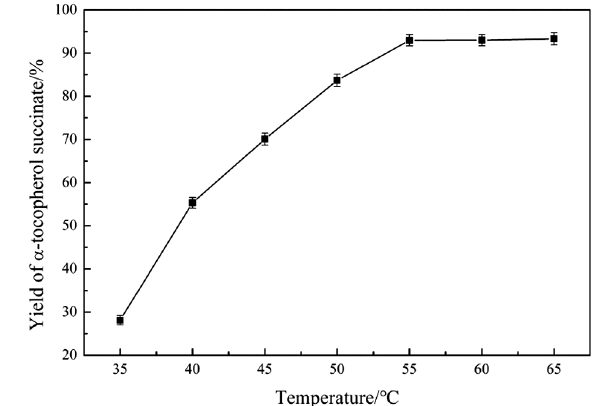
Figure 9: Effect of different temperature. Conditions of reaction: 0.15 mmol α-tocopherol, 0.45 mmol succinic anhydride, hexane/ acetone (4 mL/1 mL), 0.10 mmol NS-DMAP, nitrogen, 16